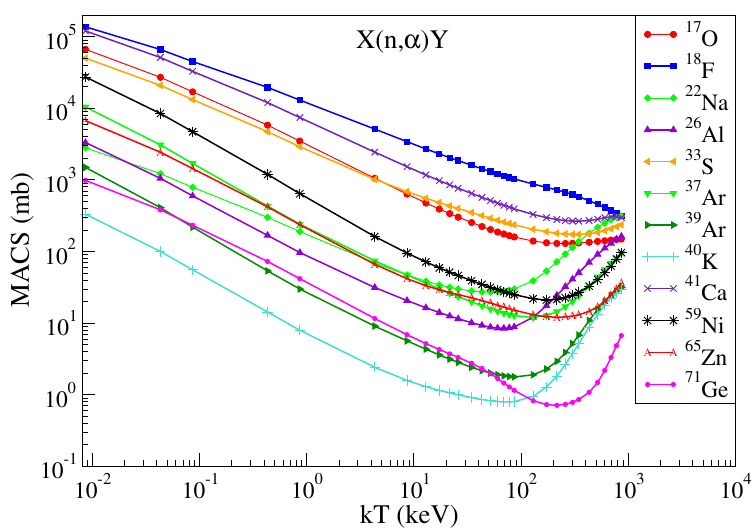
Figure 3. The ( n , α ) reaction cross sections averaged over the Maxwell-Boltzmann distribution for the set of nuclei shown as a function of